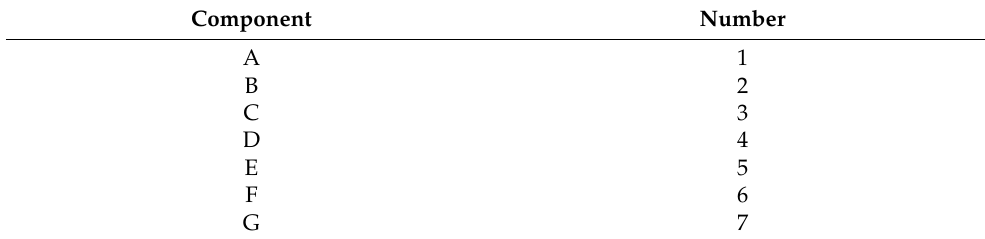
Table 1. Component number. Component